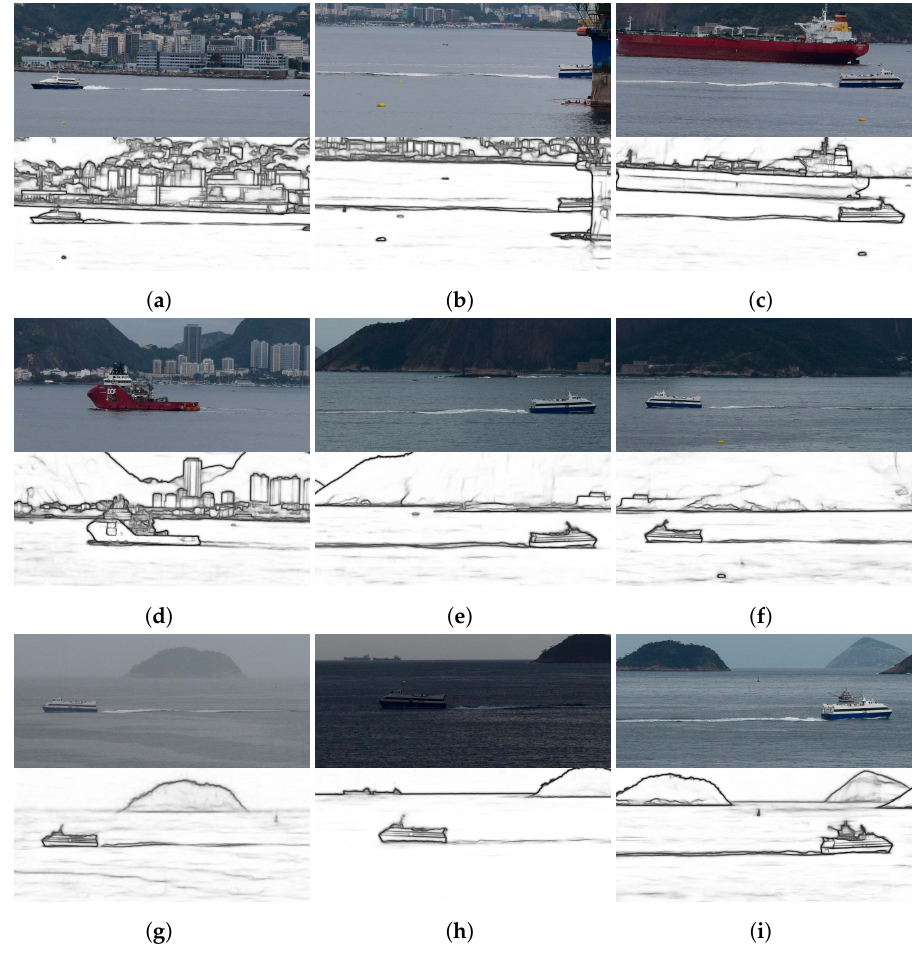
Figure 6. Cropped versions of some of the images that were used in the experiments: images i1, i9, and i10 show HSC passenger vessels; images i10, i13, i18, and i22 show MC25 passenger vessels; image i7 shows another vessel model. ( a ) Image i1; ( b ) Image i2; ( c ) Image i5; ( d ) Image i7; ( e ) Image i13; ( f ) Image i16; ( g ) Image i18; ( h ) Image i22; and ( i ) Image